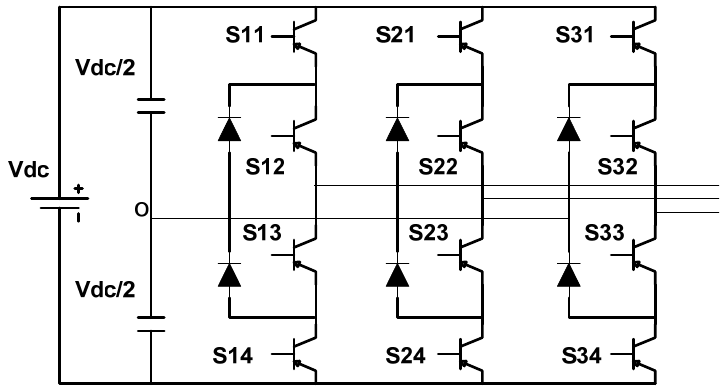
Figure 2. Three-level NPC inverter structure. Figure 2. Three‑level NPC inverter